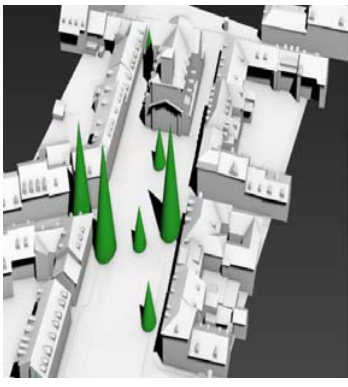
Figure 9. A technique for the visualization of pedestrian